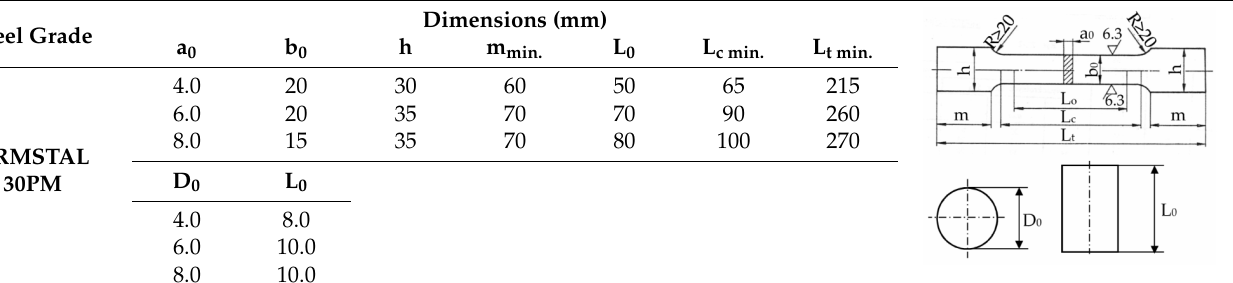
Table 4. Dimensions of the ARMSTAL 30PM samples prepared for the mechanical tests.